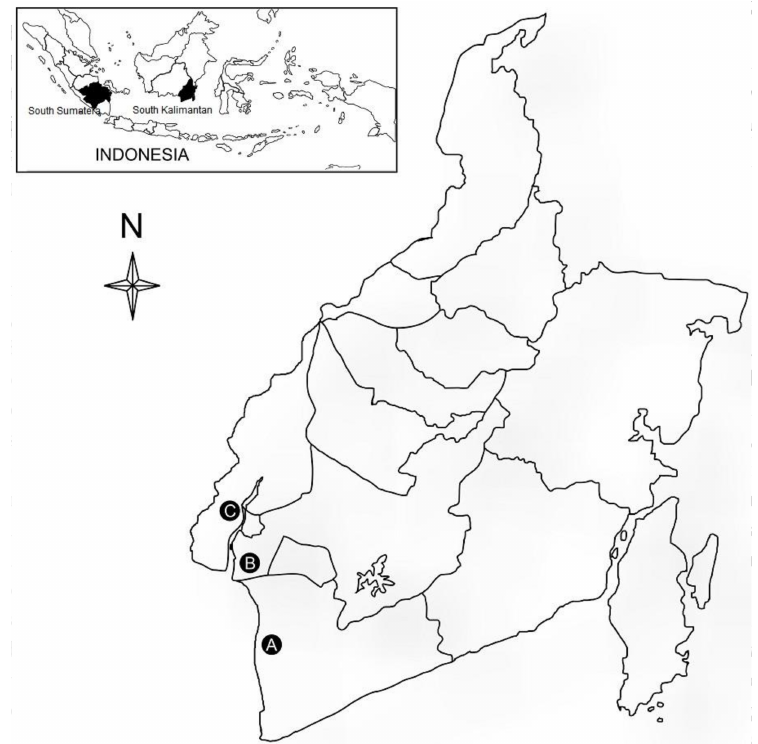
Figure 1. A map of Indonesia showing three collecting sites of the tidal swamp rice in the South Kalimantan Province, Indonesia: Tanah Laut ( A ), Banjar ( B ), and Barito Kuala ( C